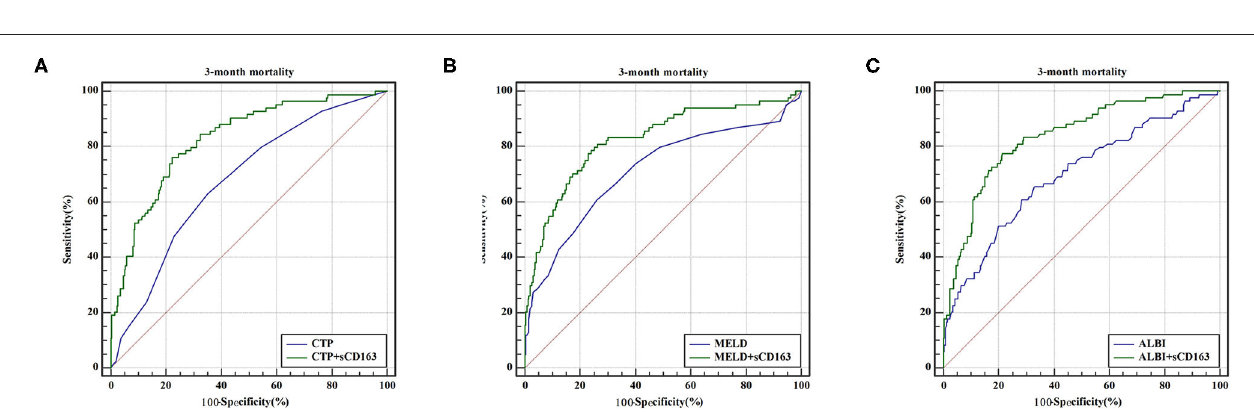
FIGURE 3 | ROC curve analysis and comparison between new scores and original scores for predicting 28-day mortality (A) ROC for CTP and CTP + sCD163; (B) ROC for MELD and MELD + sCD163; (C) ROC for ALBI and ALBI + sCD163.